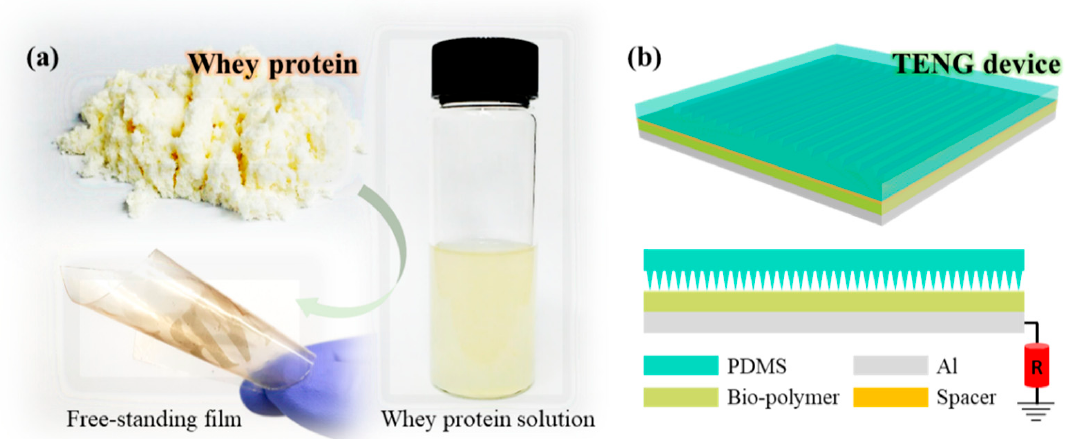
Figure 1. Concept image of the workflow. ( a ) Whey protein isolate powder dissolved in DI water and its freestanding film after preparation. ( b ) Single electrode Bio-TENG pressure device.